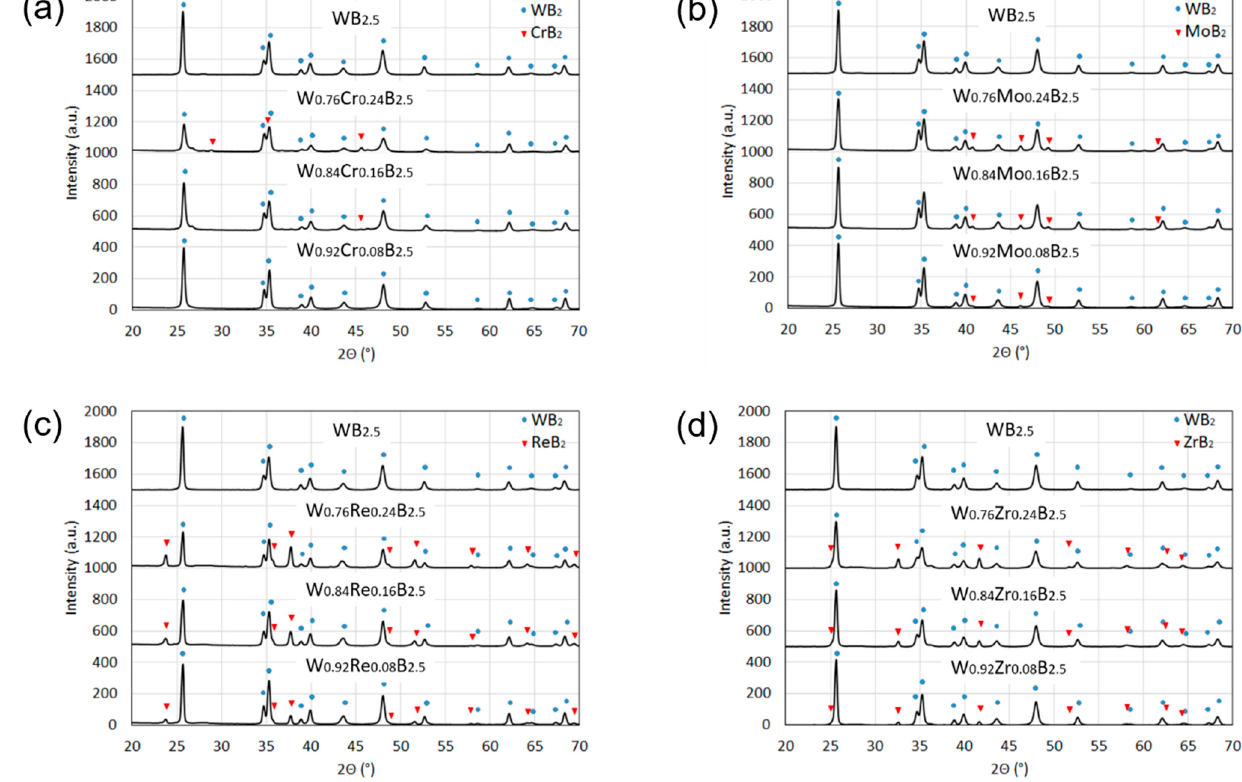
Figure 4. XRD spectra of phase composition of samples W 1 − x TM x B 2.5 with molar ratio of x = TM/(TM + W) where x = 0, 8, 16 and 24 at.% and TM: ( a ) Cr, ( b ) Mo, ( c ) Re, ( d ) Zr.